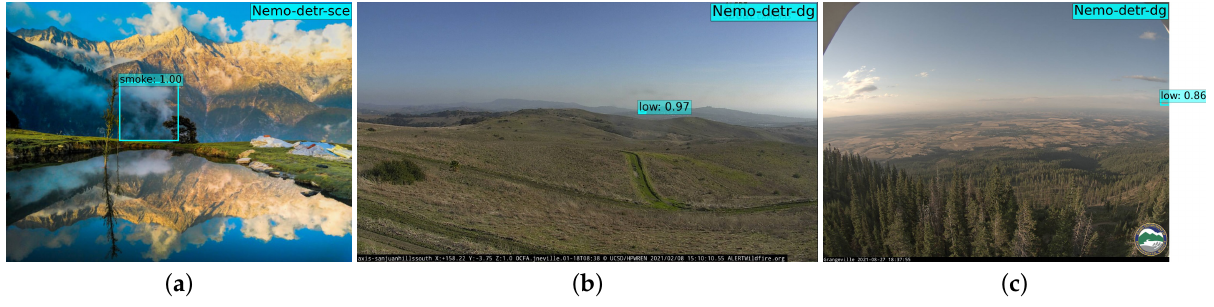
Figure 18. ( a ) Detection of cloud as smoke in an uncommon background for wildfire scenarios. All three false alarms created by Nemo-DETR-sce are of these kinds (professional nature photography). ( b ) San Juan hills south, a location not seen by our models. A white flat building near the horizon is incorrectly detected as low-density smoke. The hazy background contributed to the false detection. ( c ) Another challenging image from a camera located in Idaho. A smoke-like column of cloud on the horizon in a hazy background was detected as low-density cloud.